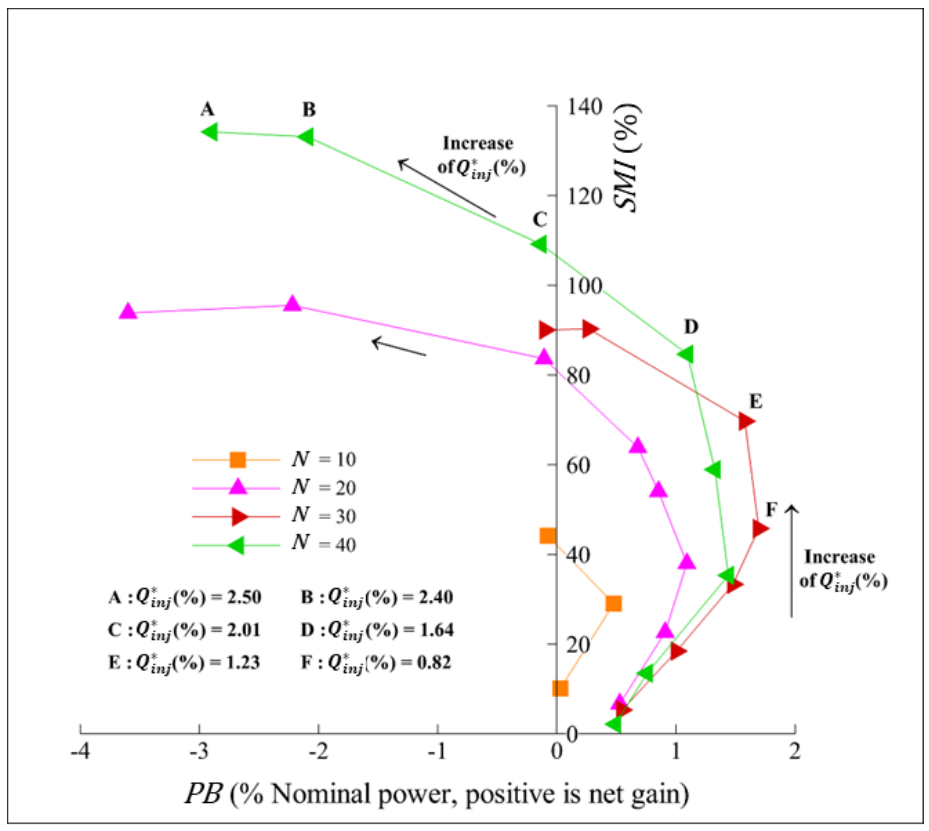
Figure 10. SMI and power balance of the control system. Continuous blowing with the absolute injection angle 𝛼 𝑗𝑒𝑡 = −30° and the rotation speed 𝛺 = 3200 rpm. N is the number of injectors ac- tivated.